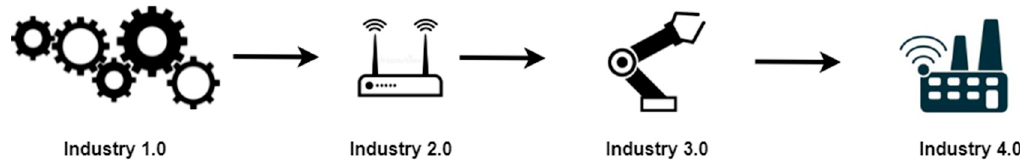
Figure 14. Industrial Evolution from Industry 1.0 to Industry 4.0.